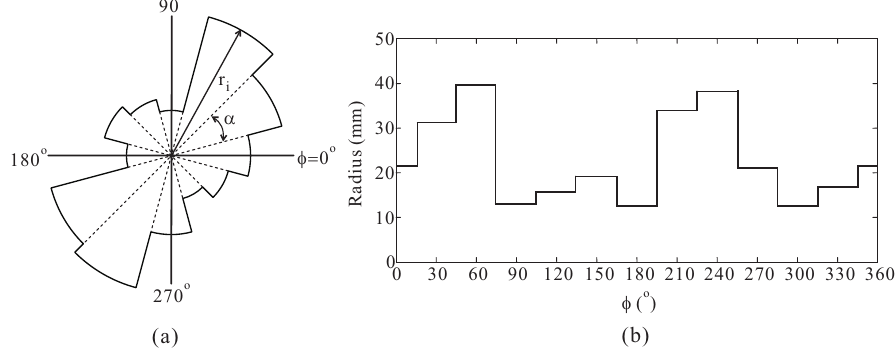
Figure 1. Multiple-circular-sector structure: ( a ) Shape of the multiple-circular-sector; ( b ) Radii at different